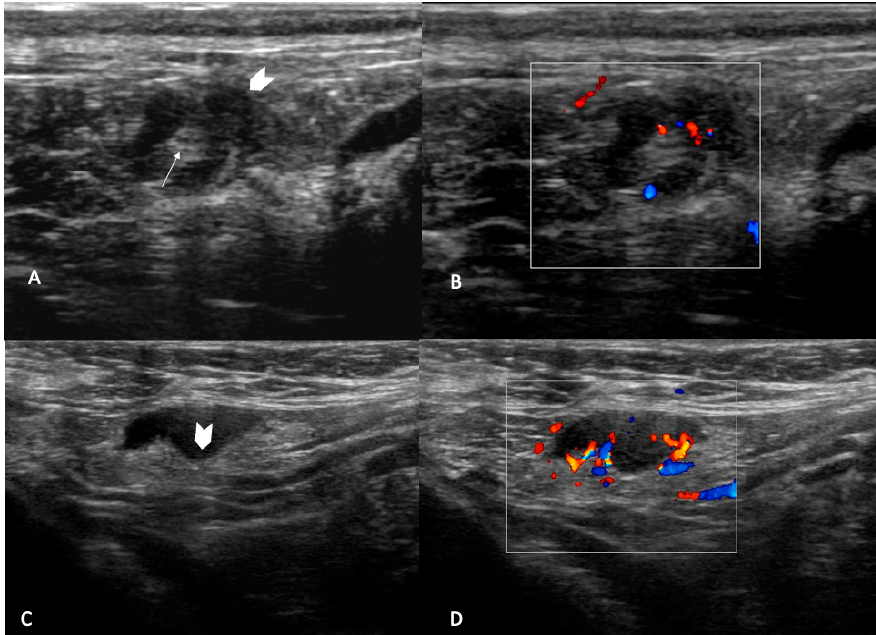
Figure 4. UN4: B-mode sonogram image shows a round, node with bulge external thickening (arrowhead) and centrally placed fatty (arrow) ( A ) and an oval node with bulge internal thickening (arrowhead) with displacement of fatty hilum ( C ). Color flow images show small vessels entering cortex of the node ( B ) and multiple branch vascularization ( D ). UN 5: Node with no fatty and vascular hilum or aberrant vascular patterns, globular shape (loss of bipolar ratio of diameters), irregular margins (Figure 5).